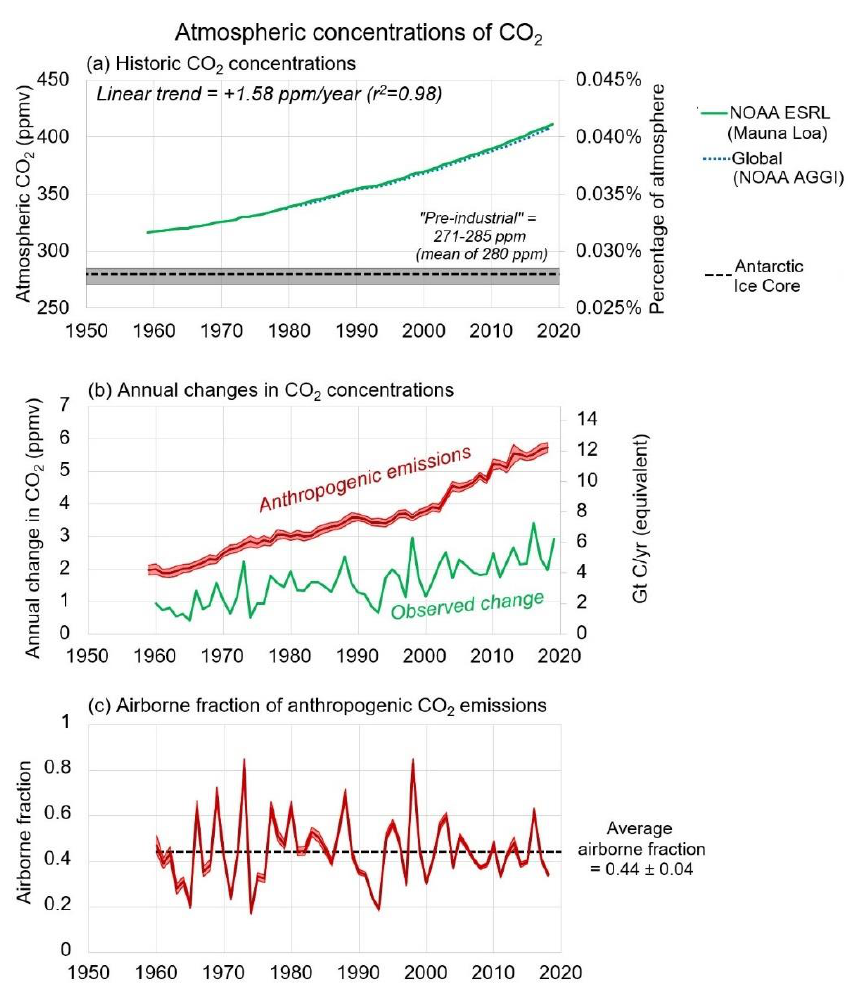
Figure 6. ( a ) Changes in annually averaged atmospheric CO 2 concentrations since direct and (almost) continuous measurements began in 1959. Estimates of pre-industrial concentrations derived from the Antarctic Law Dome ice core are shown with a grey band for comparison. ( b ) A comparison of the annual anthropogenic CO 2 emissions (red band) with the observed annual changes in atmospheric CO 2 (green line). ( c ) The “airborne fraction” for CO 2 , i.e., the fraction of anthropogenic CO 2 emissions that remained in the atmosphere for each year since 1960. The horizontal axes correspond to years.